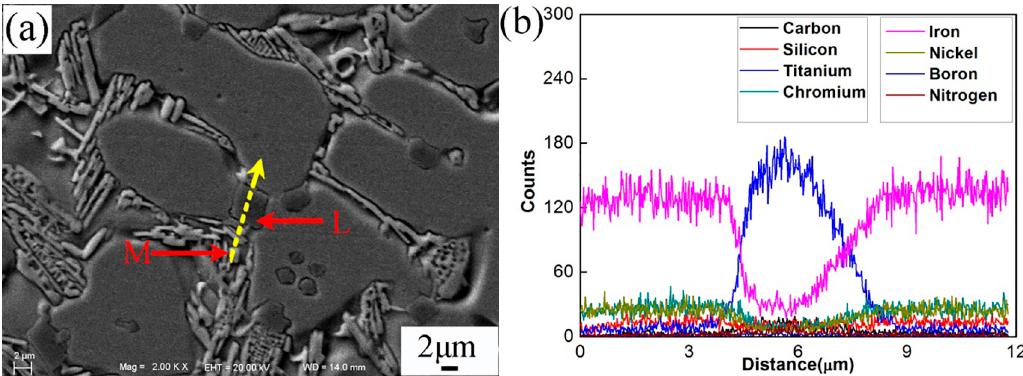
Figure 6. Magnified SEM of point G in Figure 5 and line scan of location M. ( a ) SEM of magnified cellular grains and boundary precipitates; ( b ) EDS of line M.